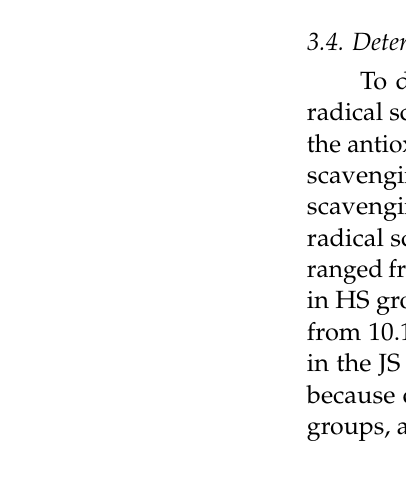
Table 3. Antioxidant capacities of the ethanolic extracts in C. lanceolata